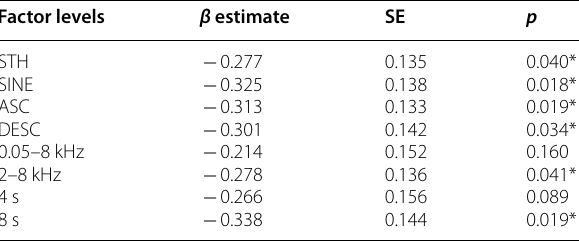
Table 3 Beta regression coefficient estimates for FEP vs HC ( N respective standard errors (SE), and p -values for all 8-factor levels used in designing the pure frequency sweep stimuli. Negative values merely reflect group order in spreadsheet (adapted from de Bustamante Simas et al., 2022)